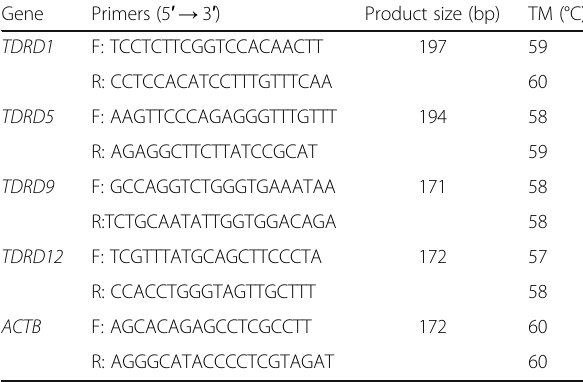
Table 2 qPCR primers used in this study